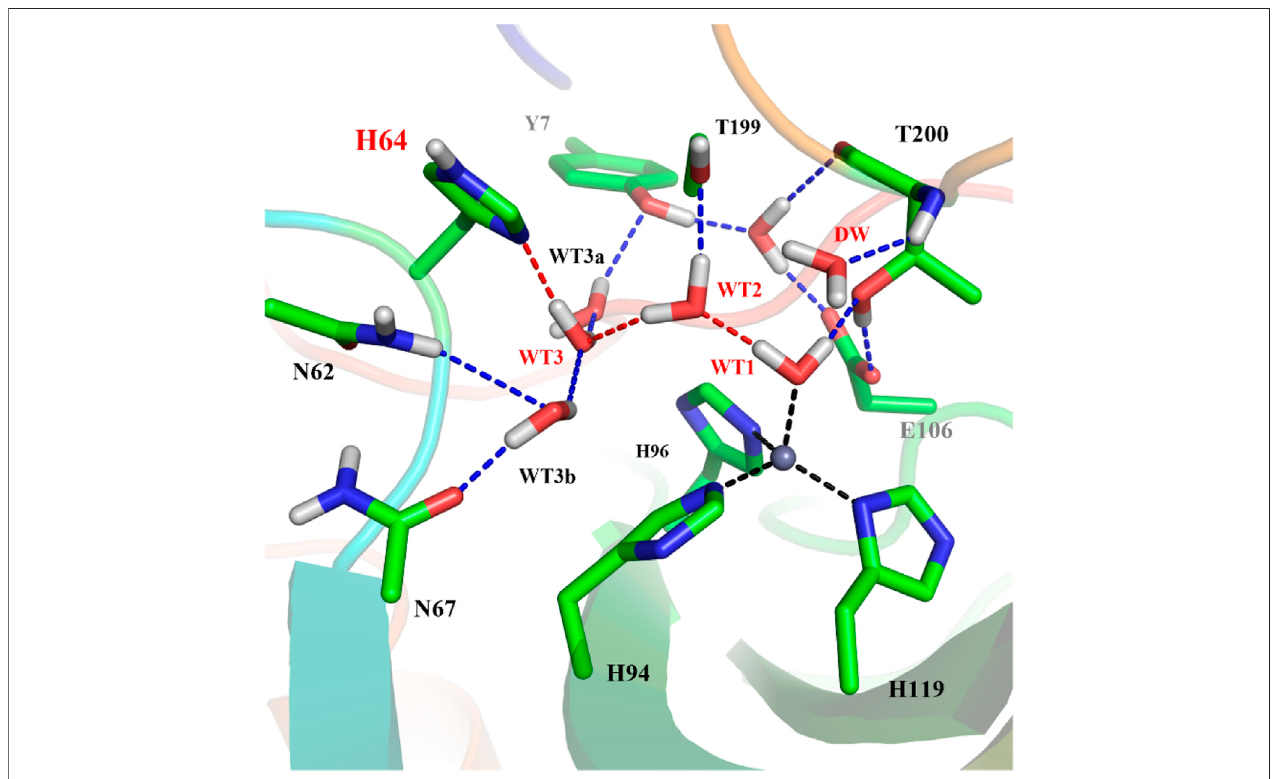
FIGURE4| Therepresent structure oftheactive sitefrom theMD simulation,where thebluedottedlines representhydrogen bonds and thered dotted linesshow the proton transfer pathway between WT1 and H64.